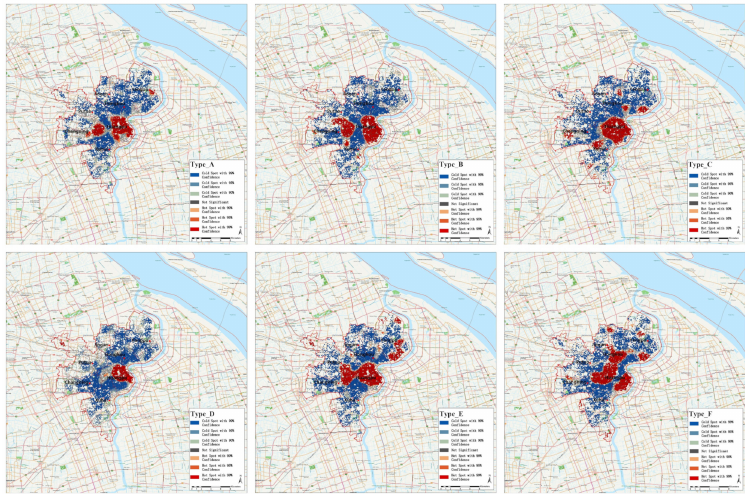
Figure 5. Results of cold and hot spot analysis: distribution of single